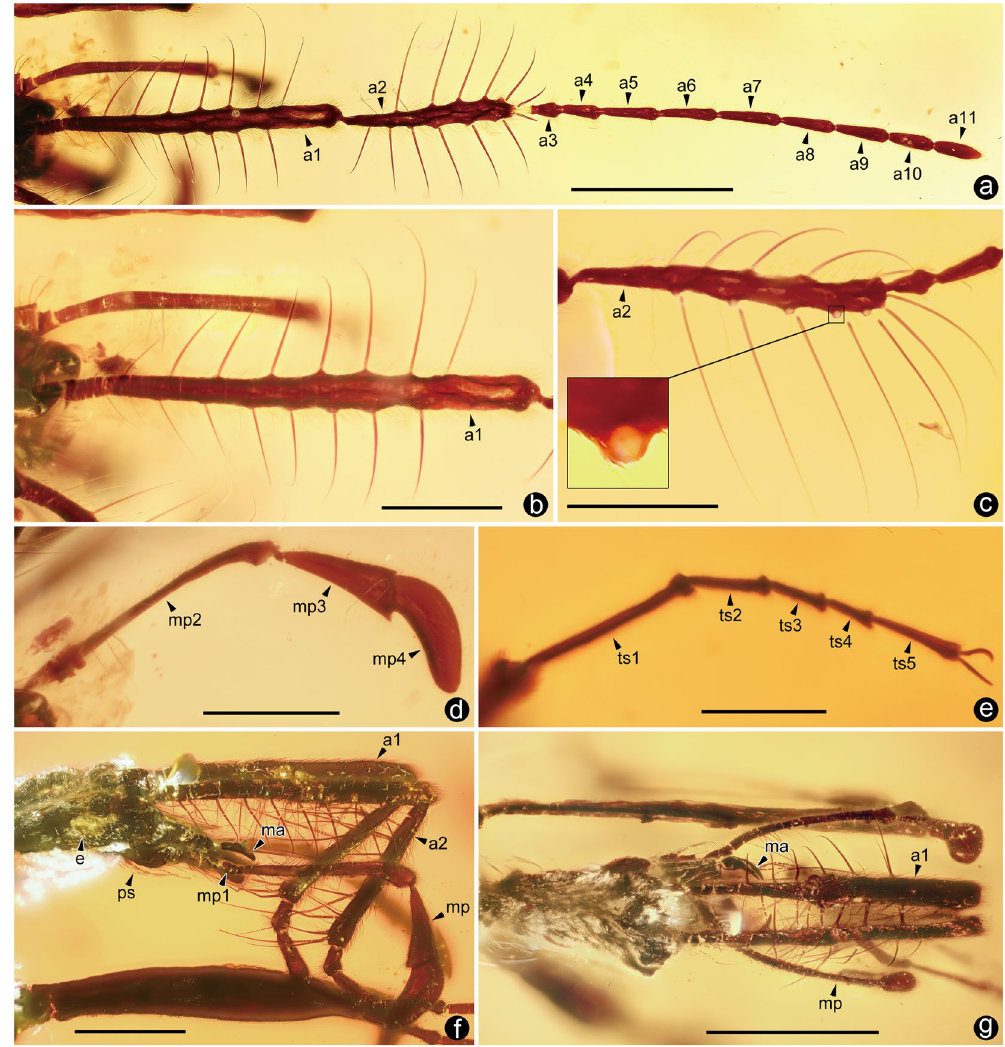
Figure 2. Morphological details of Cascomastigus monstrabilis ( a – e : male; f , g : female). ( a) Left antenna. (b) Left antennomere I. (c) Left antennomere II, and an enlarged image of a single basal socket. (d) Left maxillary palpus. (e) Right mesotarsomeres. (f) Head in lateral view, showing antennomeres I–II and maxillary palpi. (g) Same, in dorsal view. Abbreviations: a1–11, antennomeres I–XI; e, compound eye; ma, mandible; mp, maxillary palpus; mp1–4, maxillary palpomeres I–IV; ps, postgenal setae; ts1–5, tarsomeres I–V. Scale bars: 1 mm in A and E; 500 μ m in